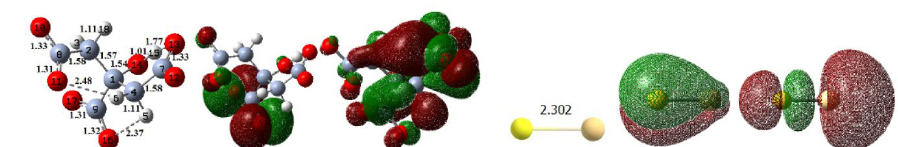
Figure 1. Selected geometrical parameters of citrate ion and CdS whereby bond lengths are in angstroms (Å). HOMO and LUMO surfaces are de- picted for both substances.